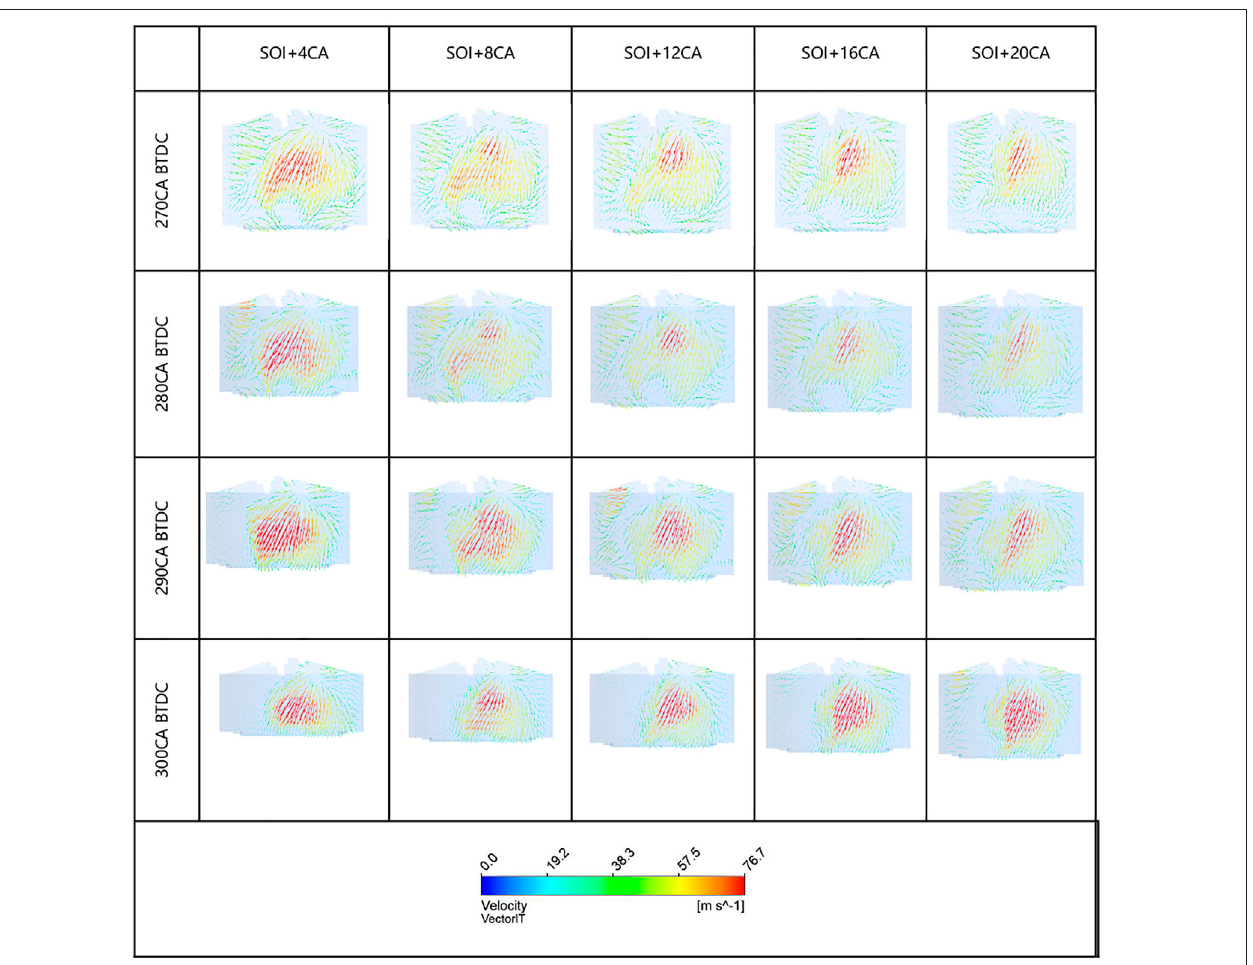
FIGURE 4 | Effect of injection timing on mixture formation at cylinder symmetry at several CA after SOI.